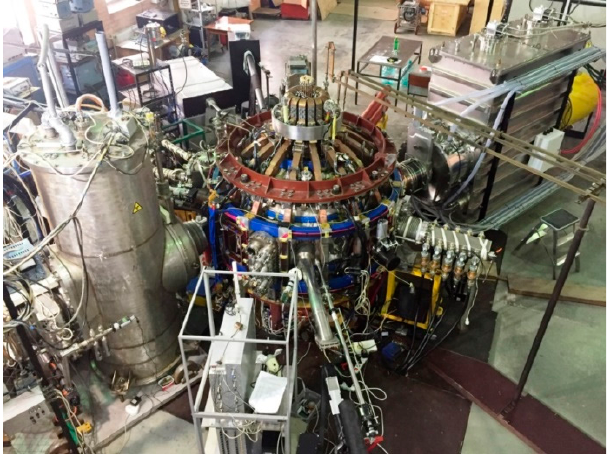
Figure 1. Globus-M2 tokamak. Figure 1. Globus‑M2